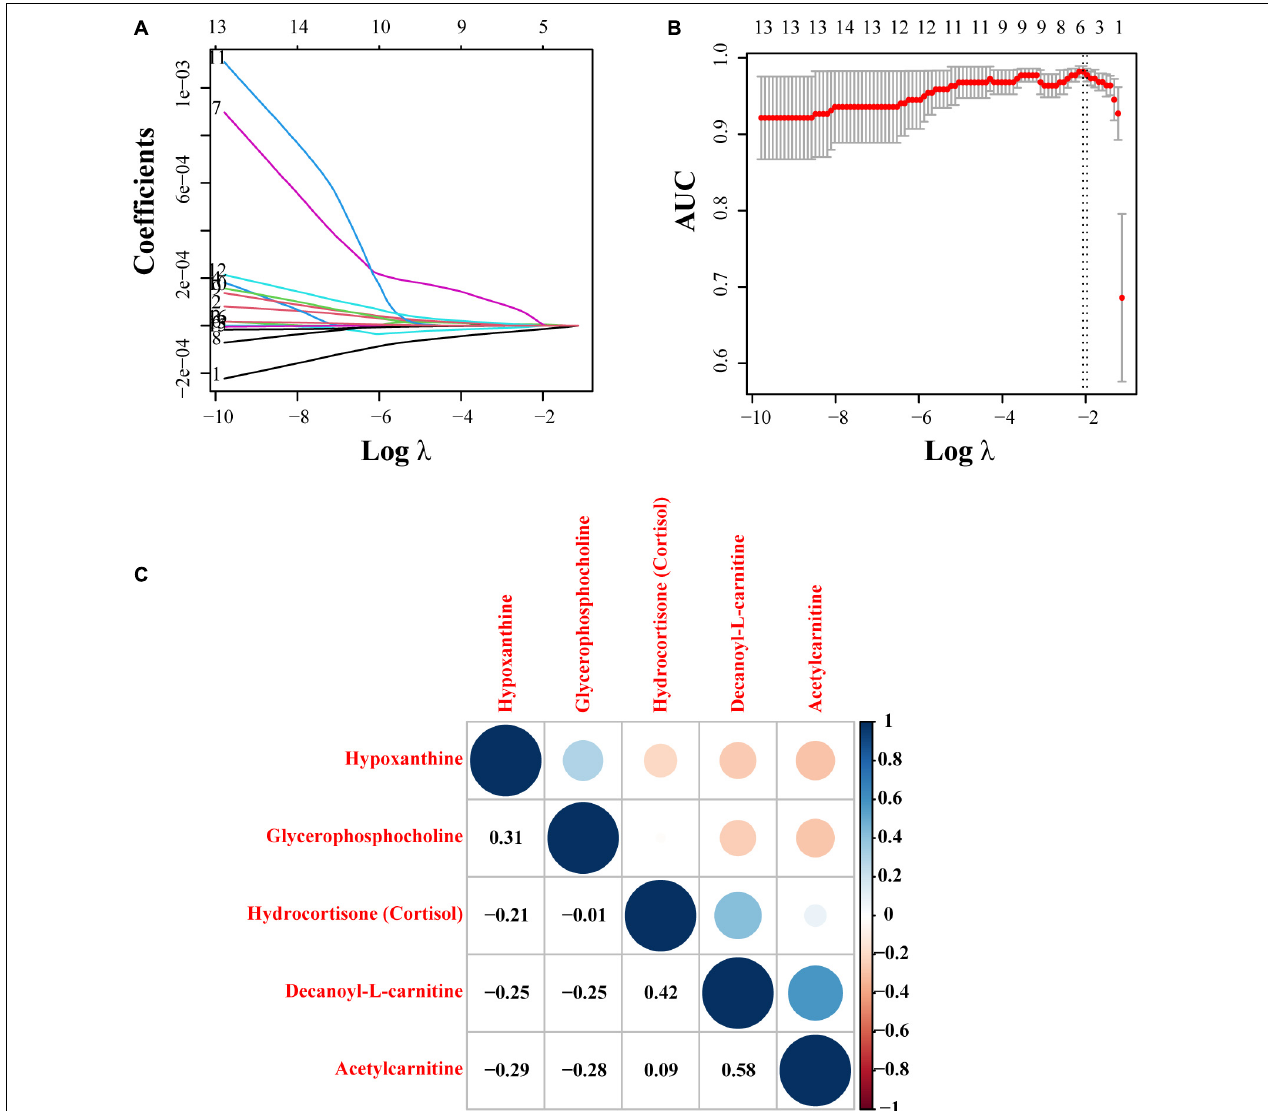
FIGURE 3 | Lasso regression model construction and correlation analysis. (A) The process of fitting the lasso regression model. Each curve represented a metabolite. (B) Partial likelihood deviance was calculated by the cross-validation for the best λ to determine the minimum mean cross-validated error. Red dots and solid vertical lines referred to partial likelihood deviance and corresponding 95% CI, respectively. In addition, the left and right dotted vertical lines represented the λ value with minimum cvm (namely, lambda.min) and the largest value, whose error was within one standard error of the minimum (lambda.1se). (C) The correlation figure revealed the correlation of expression pattern of five selected metabolites. Red represented a positive correlation, and blue showed a negative correlation. The size of the point was proportional to the correlation